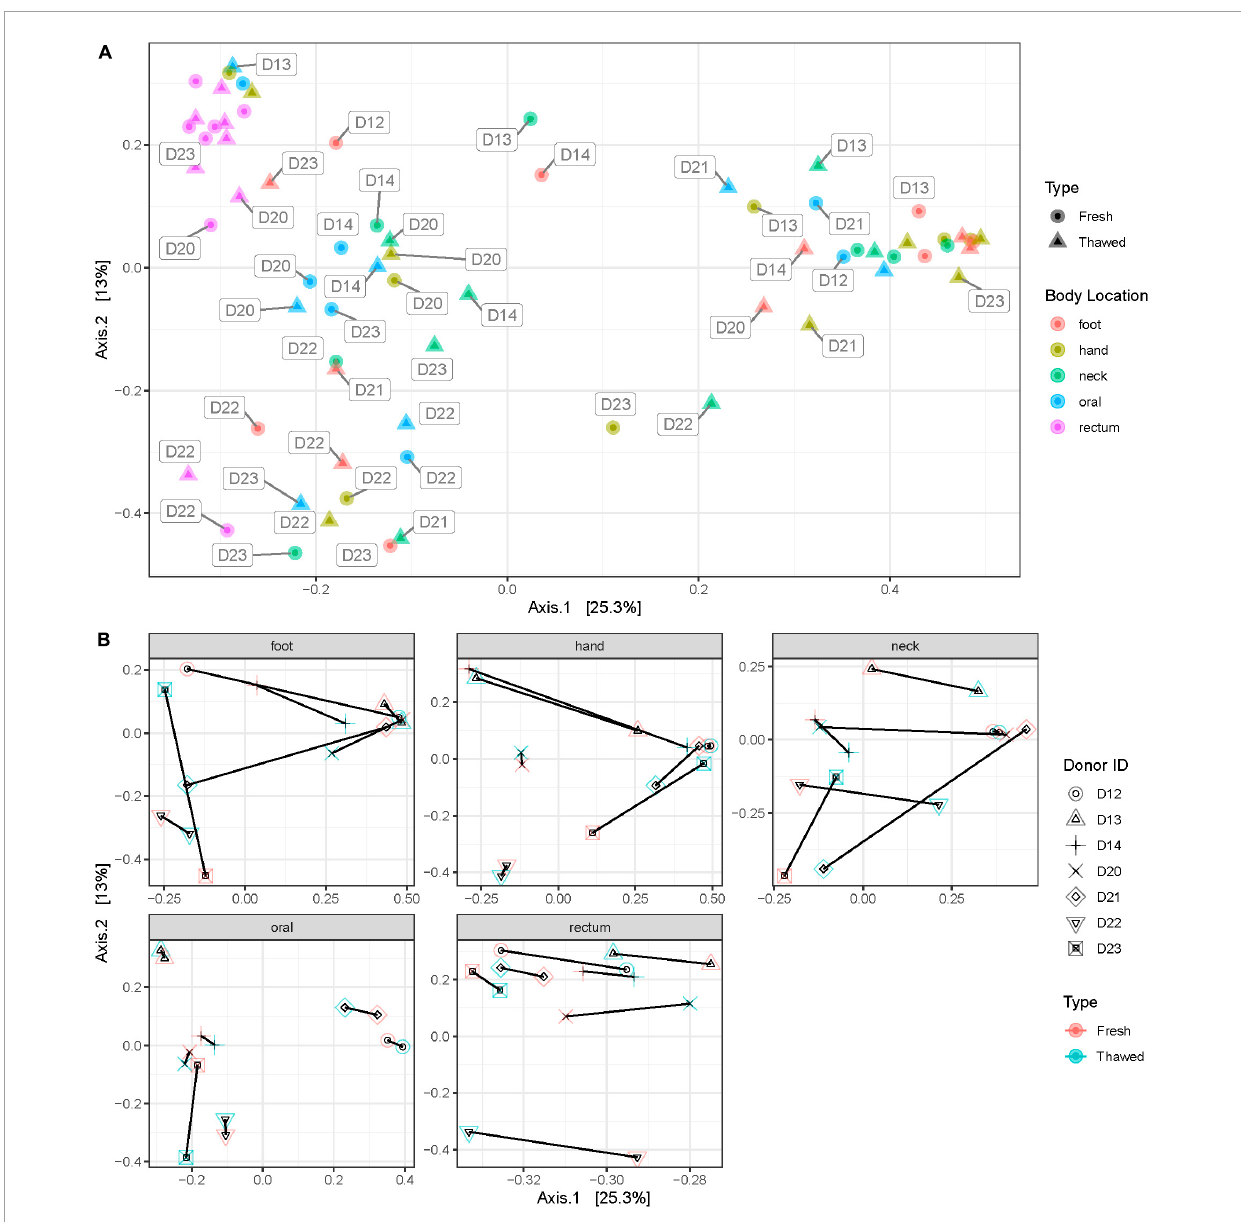
FIGURE4 Bray–Curtis distance plot of samples at each anatomical location (A) and plots showing shift in donor microbial community after freezing at each anatomical location (B)